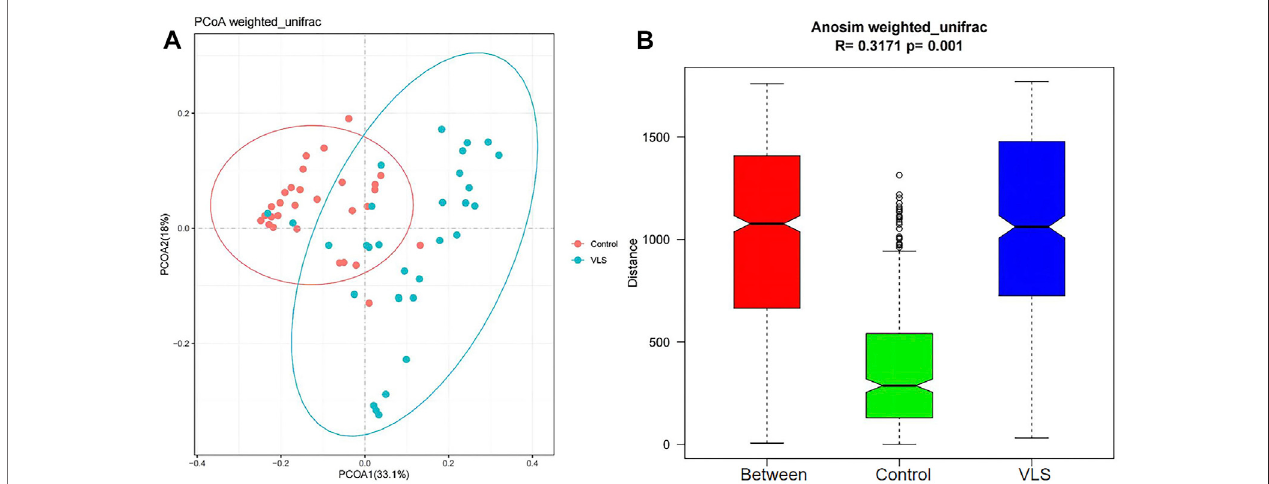
FIGURE 3 | (A) The results of principal coordinate analysis (PCoA) based on weighted UniFrac showed that the bacterial microbiome clustered separately in the VLSandcontrolgroups. (B) TheplotofANOSIManalysismeasuredthe β diversityofvulvarmicrobiotabetweentheVLSandcontrolgroups.(TheBetweencolumnisthe merged information of the two groups.)